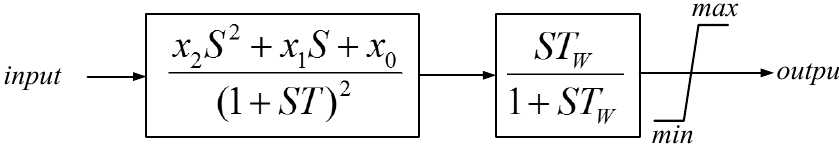
Figure 2. Block diagram of the SSSC stabilizer.